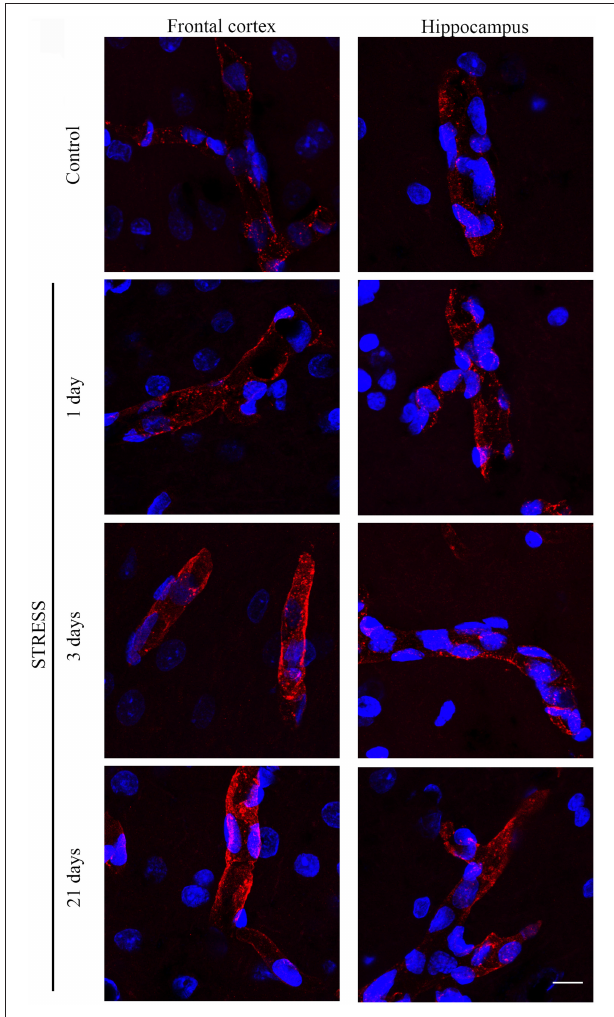
FIGURE 6 | Effect of restraint stress on GLUT-1 immunostaining of brain capillaries in the rat frontal cortex and hippocampus. Glucose transporter-1 receptor was immunostained on brain sections of control and stressed rats. Red color: immunostaining for GLUT-1. Blue color: cell nuclei stained with Hoechst dye 33342. Scale bar: 15 µ m.